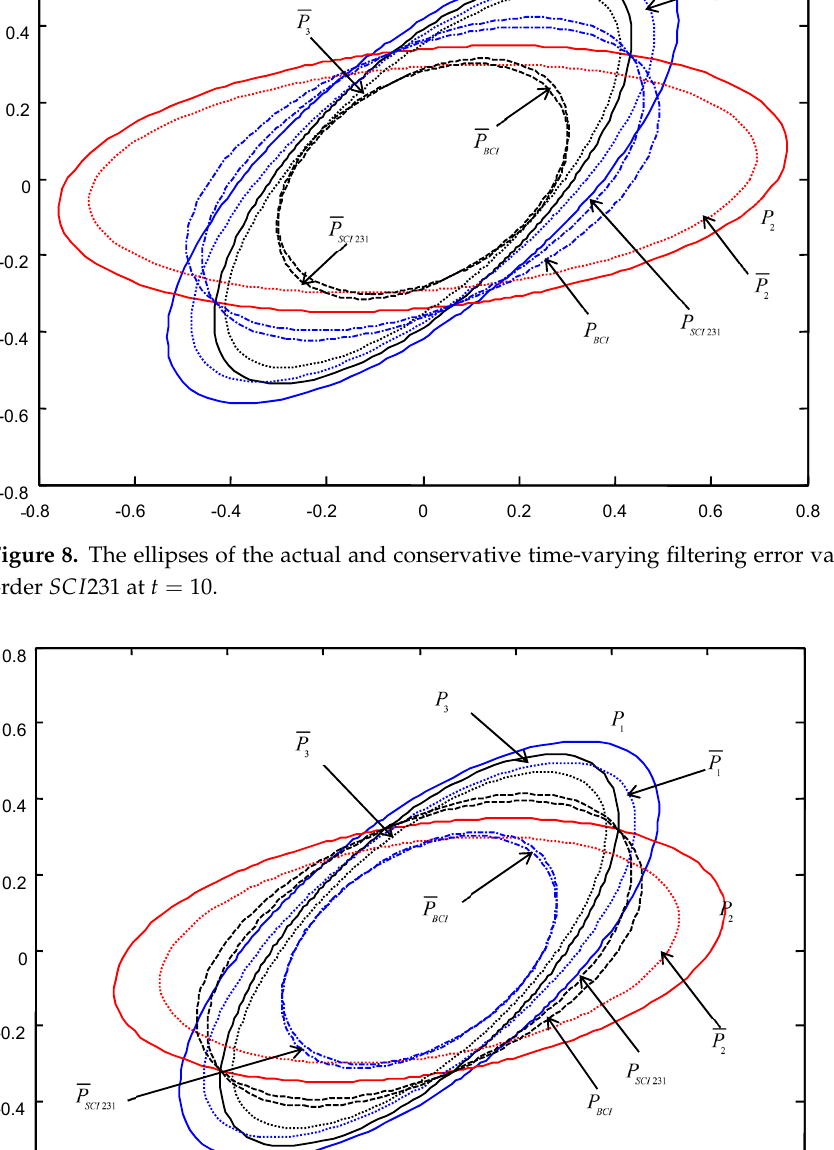
Figure 7. The ellipses of the actual and conservative steady ‐ state filtering error variances of the order 132 SCI .